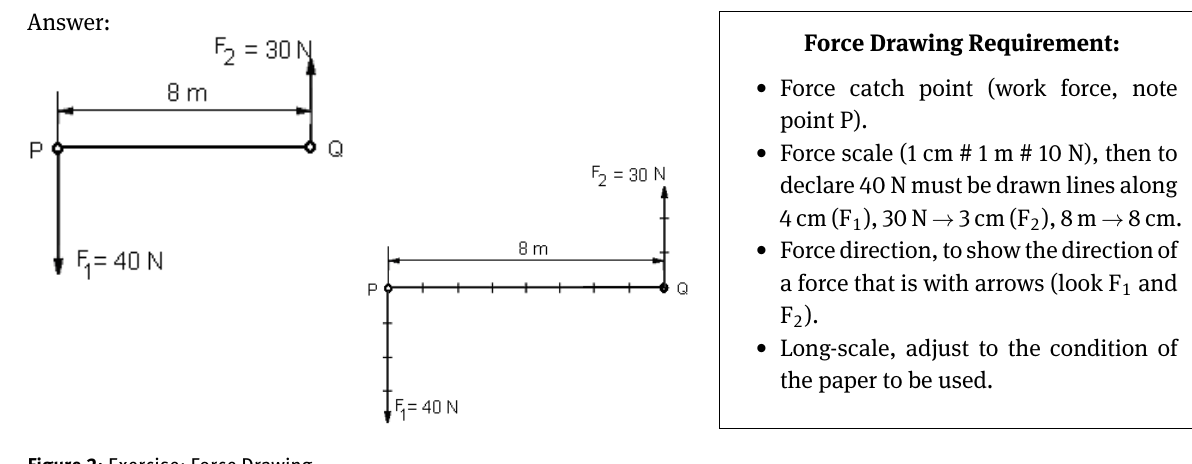
Figure 2: Exercise: Force Drawing.